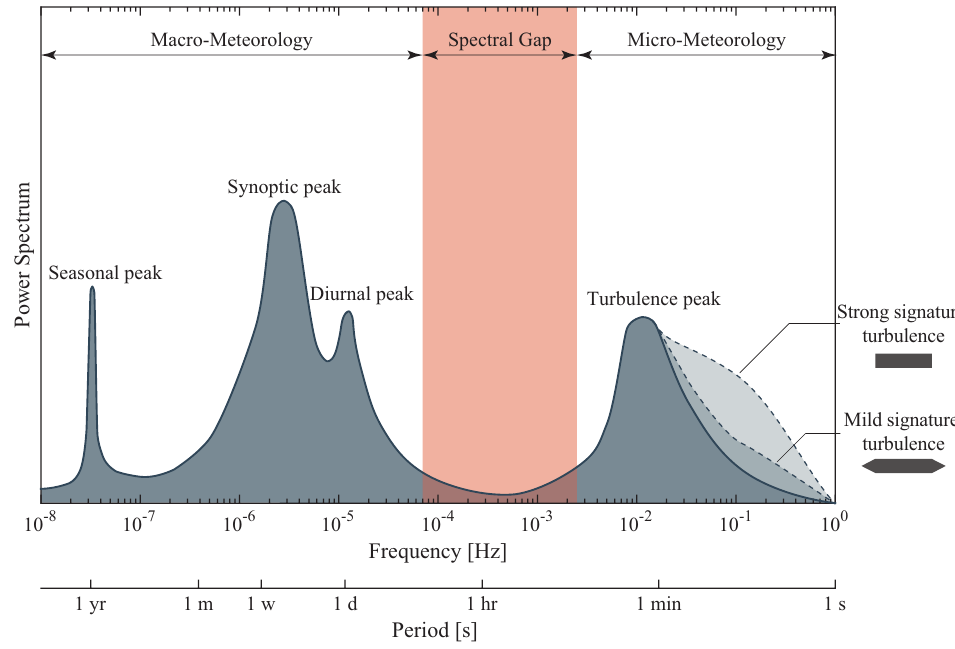
Figure 1. Surface pressure